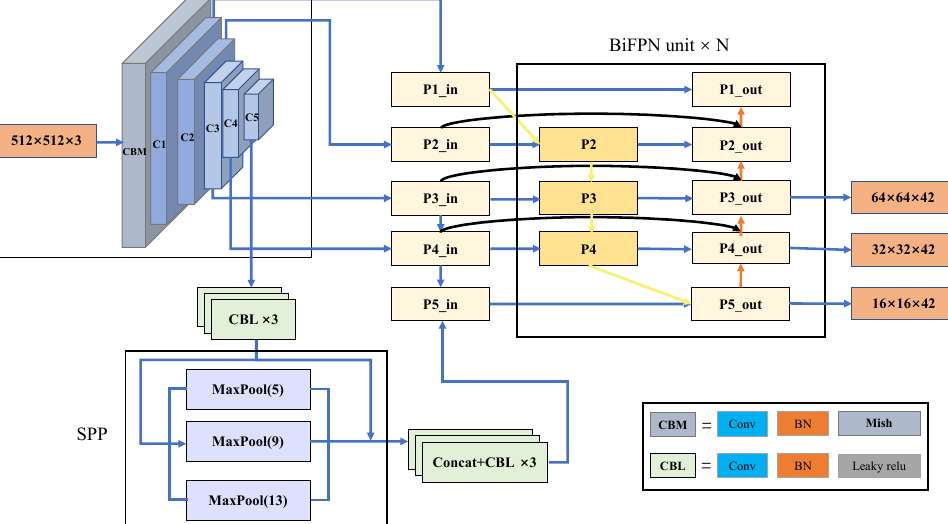
Figure 1. Architecture of improved YOLOv4.